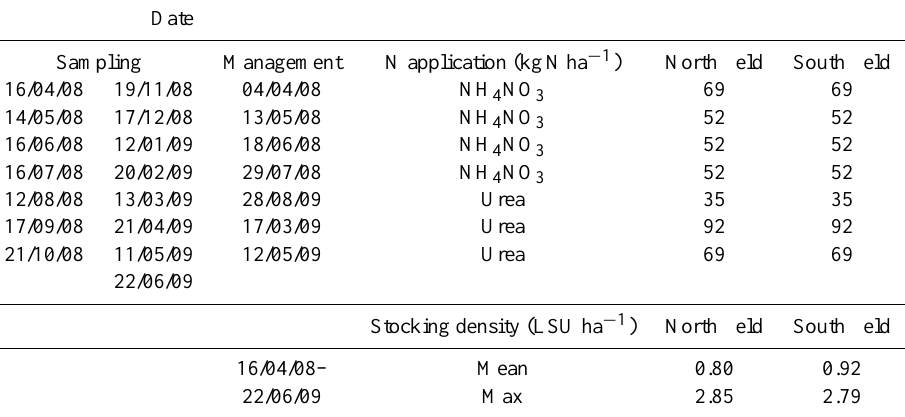
Table 1. Dates of sampling and agronomic management (N application and grazing) in North and South fields. Data provided by Centre for Ecology & Hydrology, Edinburgh,